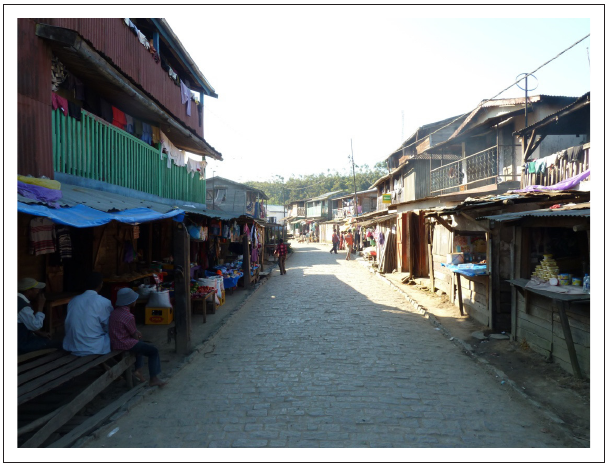
FIGURE 4: Main access road in Andasibe village which has been improved via funding from tourism profits. Roads in Madagascar can be extremely rutted with many pot holes, which become waterlogged when wet and shedding dust when dry. Hardening and sealing main access roads is a considerable improvement to village access and functionality.